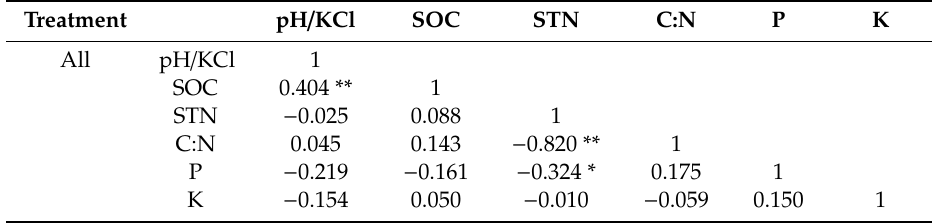
Table 8. Pearson correlation coe ffi cient (r-values) and significance* among soil variables (n all